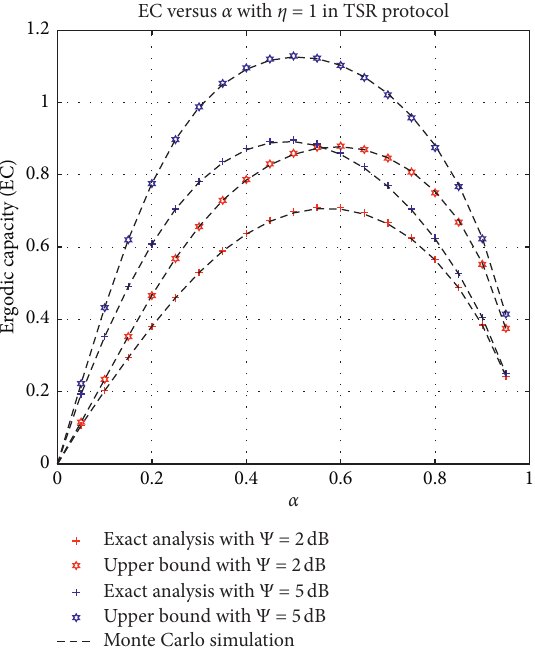
Figure 6: Ergodic capacity versus ρ for PSR protocol. Figure 7: Ergodic capacity versus α for TSR